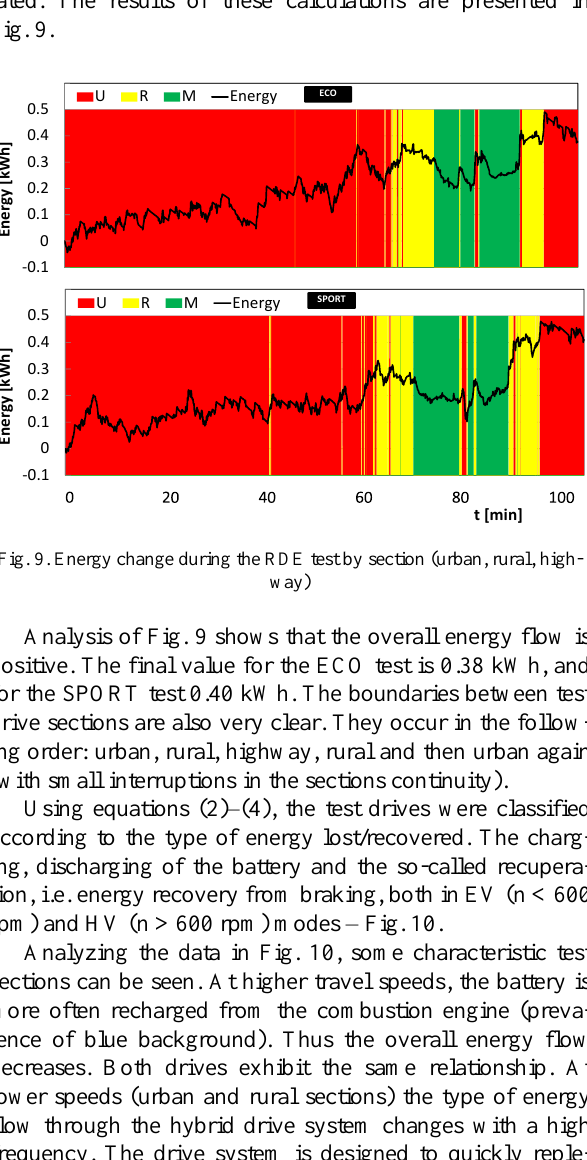
Fig. 7. The percentage share of individual driving modes in relation to the total test travel time